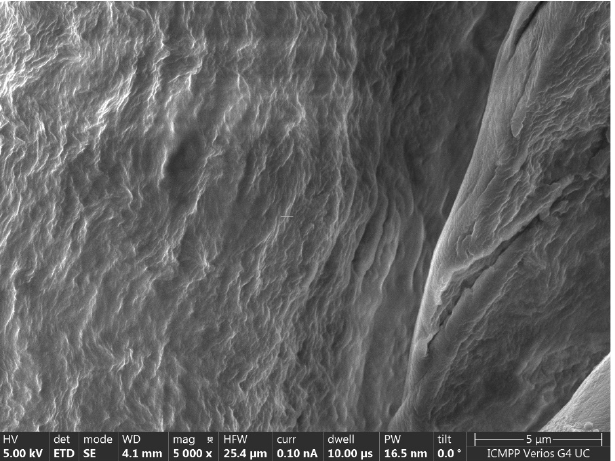
Figure 4. The SEM images of